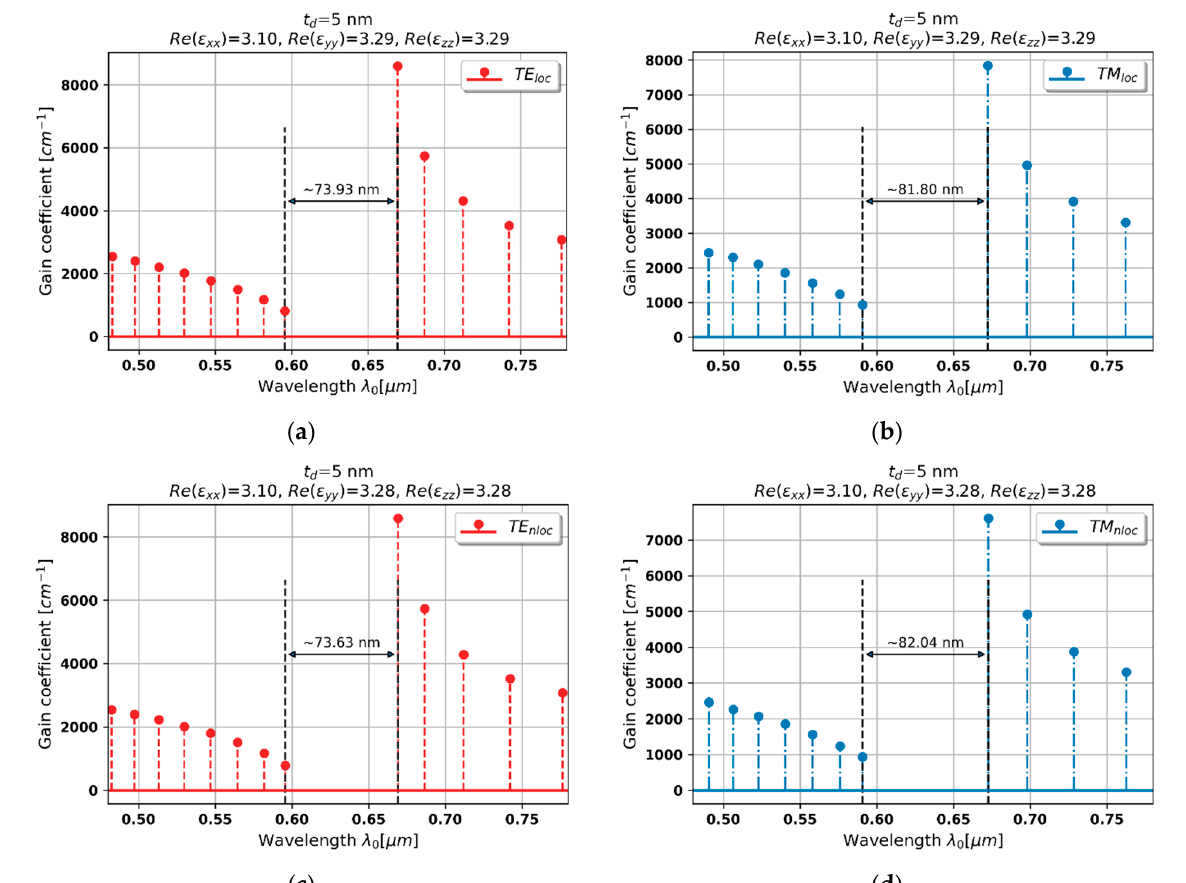
Figure 4. Modal spectra for TE ( a , c ) and TM-polarized light ( b , d ) for a PHC laser based on hyper- bolic medium with 𝑡 (cid:3027)(cid:3041)(cid:3016) = 5 nm dielectric layer (black double-headed arrow denotes spectral width of stop band of the spectrum).